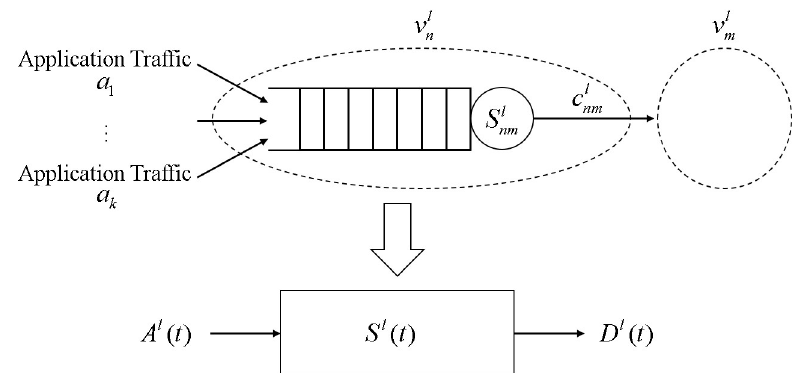
Figure 2. Switch system